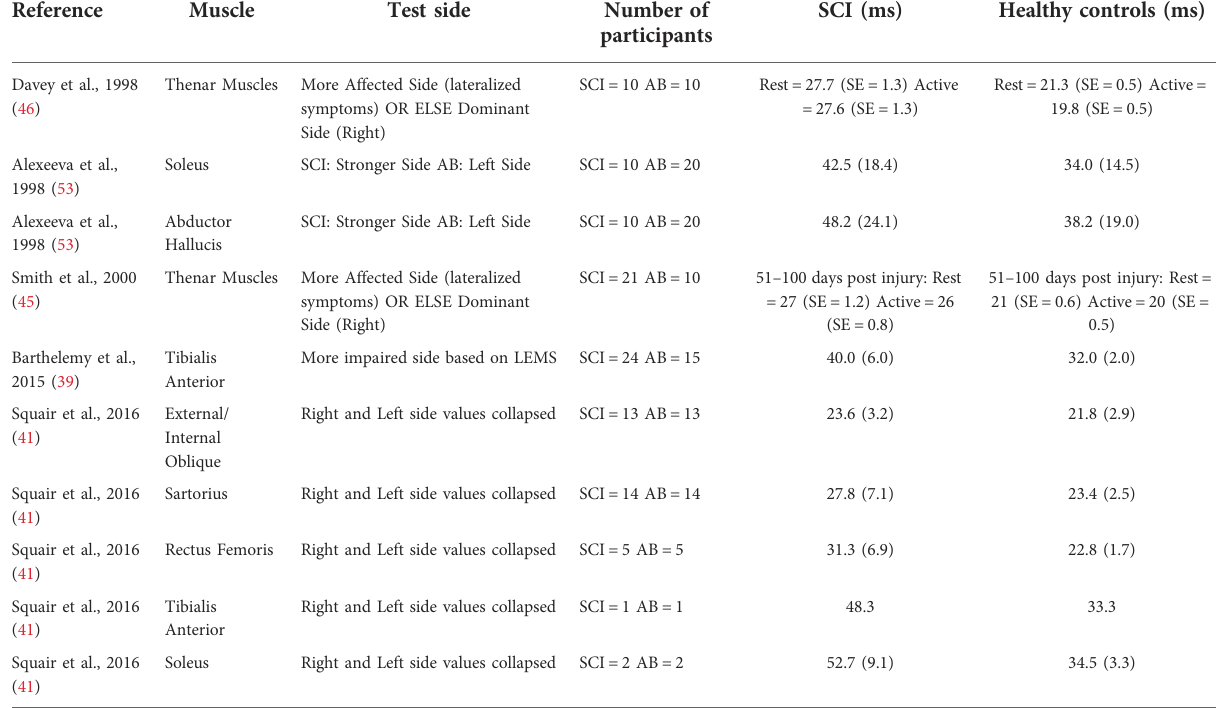
TABLE 3 Motor evoked potential latency in individuals with and without spinal cord